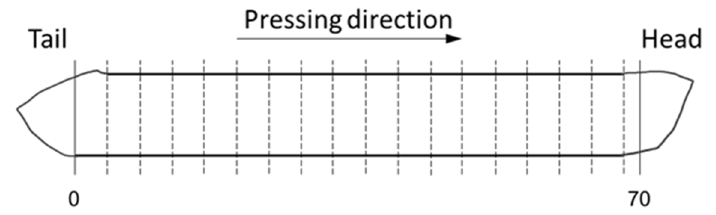
Figure 10. Schematic illustration showing the cross-sections in the analysis for the steady-state